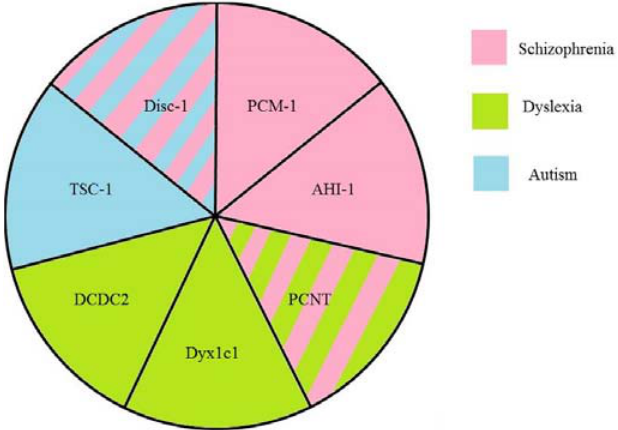
Figure 3. A scheme of suggested associations between the ciliary proteins and neurodevelopmental diseases. Striped sectors indicate that the protein is associated with at least two diseases. Note different location in the cilia or protein complexes of those ciliary proteins related to different diseases.